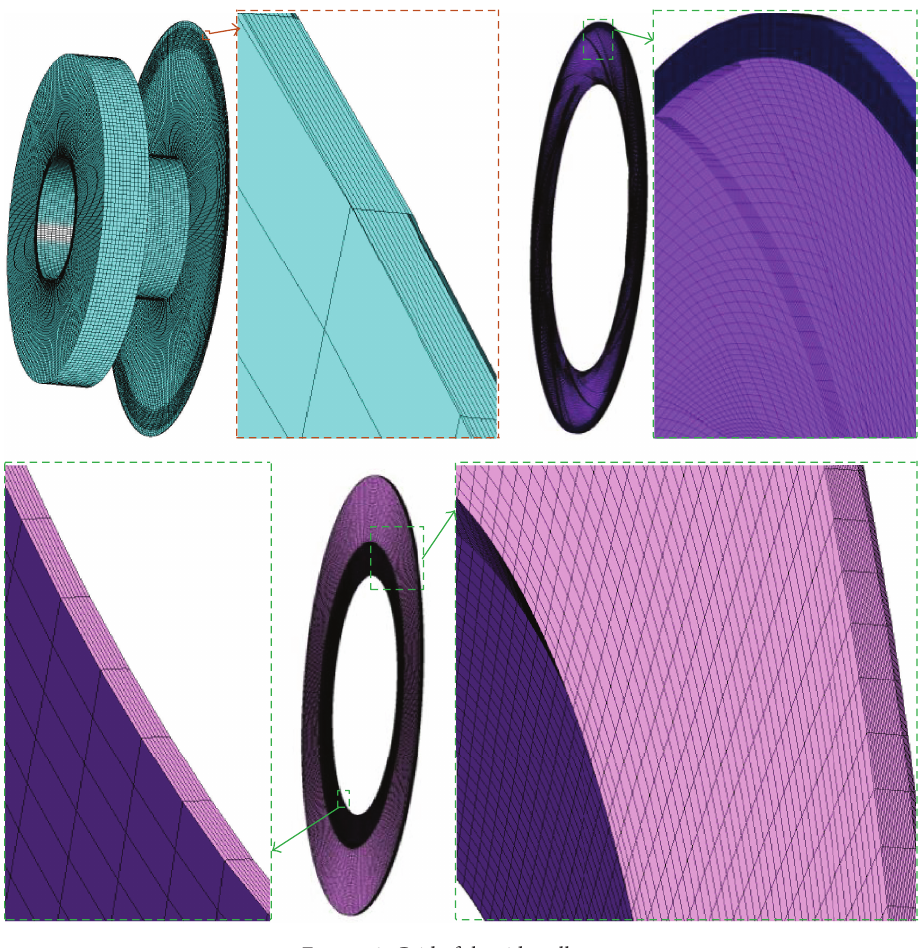
Figure 2: Grid of the sidewall gaps.